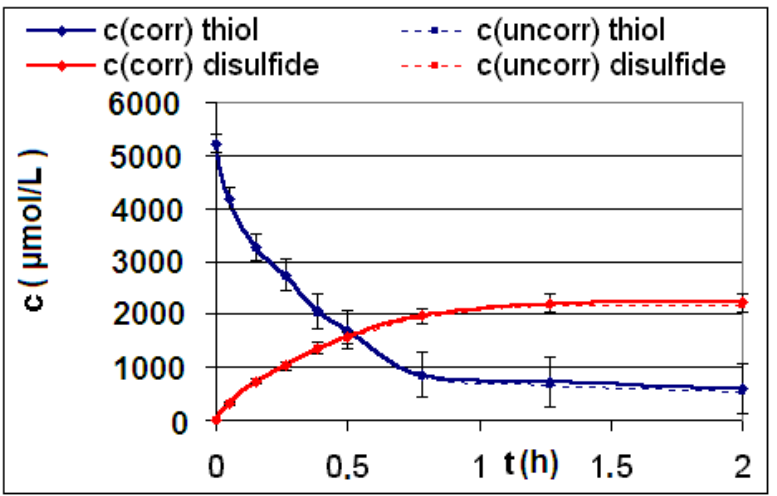
( t ) /c ( t ) . corr uncorr